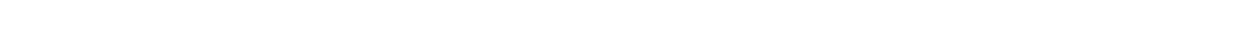
Fig. 1 MBCs scan SCS macrophages for antigen. a Tiled maximum intensity projection (3072 × 2048 × 141 μ m) of lymph node 70 days after HEL-OVA primary immunisation. MBC spots (white), CD169 + SCS macrophages (pink), SHG (blue). See also Supplementary Movie 1. Scale bar = 500 μ m. b Maximum intensity projection (300 × 300 × 48 μ m) of follicle 32 days after HEL-OVA immunisation. MBC SW HEL tracks (red), naive SW HEL B cell tracks (green), CD169 + SCS macrophages (pink), SHG (blue). See also Supplementary Movie 2. Scale bar = 50 μ m. c Proportion of naive B cells (blue) or MBCs (red) in proximity (<20 μ m) to CD169 + SCS macrophage surface at any given time point, number time points = 46, quanti fi ed from b where number naive cells = 74, number MBCs = 40. Box plots show centre line as median, box limits as upper and lower quartiles, whiskers as minimum to maximum values. d Maximum intensity projection of follicle 54 days after HEL-OVA primary immunisation, showing colocalisation (white) of a MBC (red) with CD169 + SCS macrophages (pink) over time. Interactions with three different SCS macrophages are highlighted in shades of pink. See also Supplementary Movie 3. Scale bar = 5 μ m. e Speed of MBCs segmented based on distance from CD169 + SCS macrophage surface: far (<20 μ m) (red) or close (>20 μ m) (blue). Number of data points = 1827. Data are combined from 4 movies. Comparison between groups utilised one-tailed unpaired Student ’ s t -test. f Arrest coef fi cient of naive B cells (blue) or MBCs (red), de fi ned as percentage of time a cell slowed down to <3 μ m/min. Number of naive cells = 733, MBCs = 202. Data are pooled from 4 movies. Comparison between groups utilised one-tailed unpaired Student ’ s t -test. g Number of donor-derived MBCs in draining inguinal lymph node (dLN) (red) compared to non-draining popliteal lymph node (ndLN) (blue). Data are from 15 mice and representative of 2 independent experiments. Comparison between groups utilised one-tailed unpaired Student ’ s t -test. h Identi fi cation of unphotoconverted Kaede green MBCs, photoconverted Kaede red MBCs and endogenous B cells in the draining lymph node by FACs analysis, example shown is 2 days after photoconversion. Box plots show centre line as median, box limits as upper and lower quartiles, whiskers as minimum to maximum values. i Kaede MBCs in the draining lymph node were photoconverted, allowed to recover from anesthesia and then harvested 1 – 4 days later. Graph shows proportion of photoconverted cells to non-photoconverted cells in the lymph node at indicated time